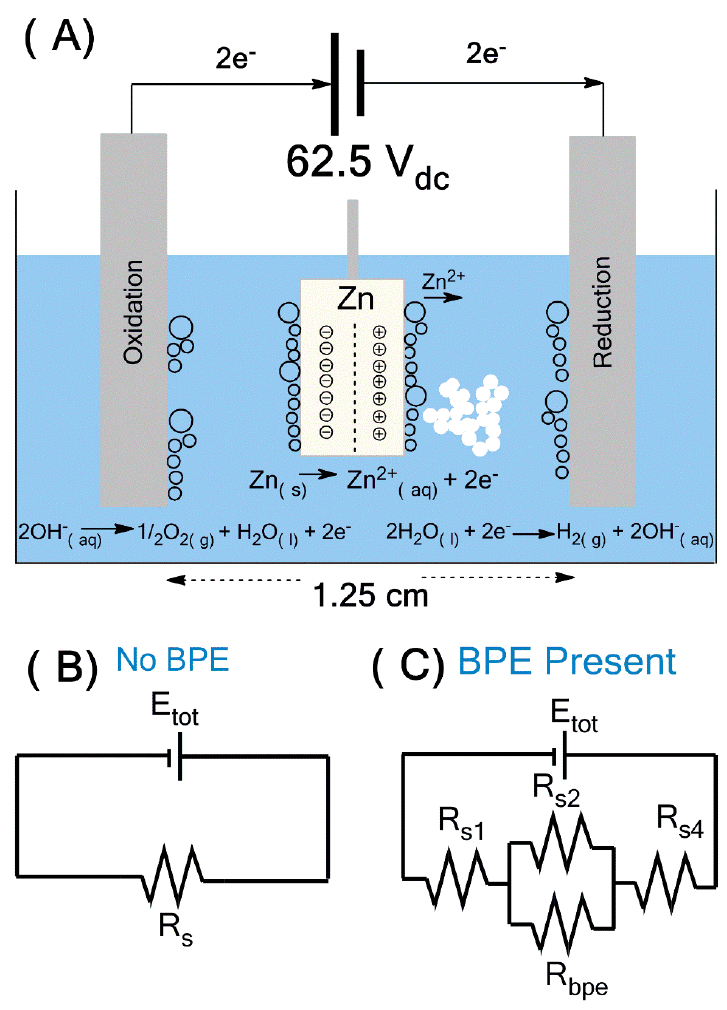
Figure 1. Electrochemical bipolar setup for the synthesis of ZnO ( A ), and an electrical equivalent circuit representing resistances to current flow in a bipolar electrochemical cell without ( B ) and with bipolar electrode ( C ).